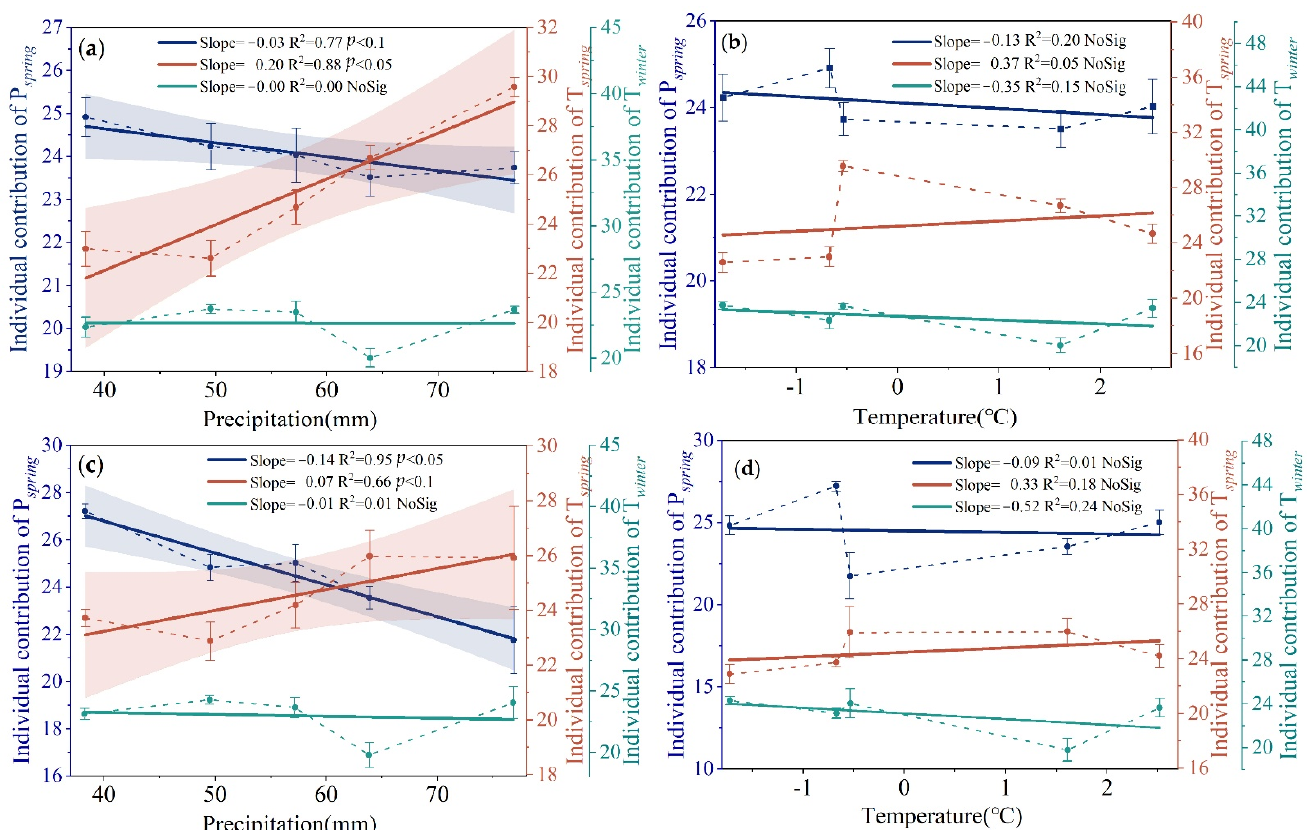
Figure 7. Variations in individual contribution of each climate factors for meadow ( a , b ) and steppe ( c , d ) to long-term average cumulative precipitation and mean temperature in spring in different ecoregions across Tibetan Plateau. Each point shows averaged values of pixels with significant individual contribution at p < 0.05 level for meadow and steppe in different ecoregion. Error bar is SEM (standard error of mean). Line represents linear regression, and shaded area represents 95% confidence interval. p value denotes significance. NoSig indicates that slope is not significant ( p ≥ 0.05).